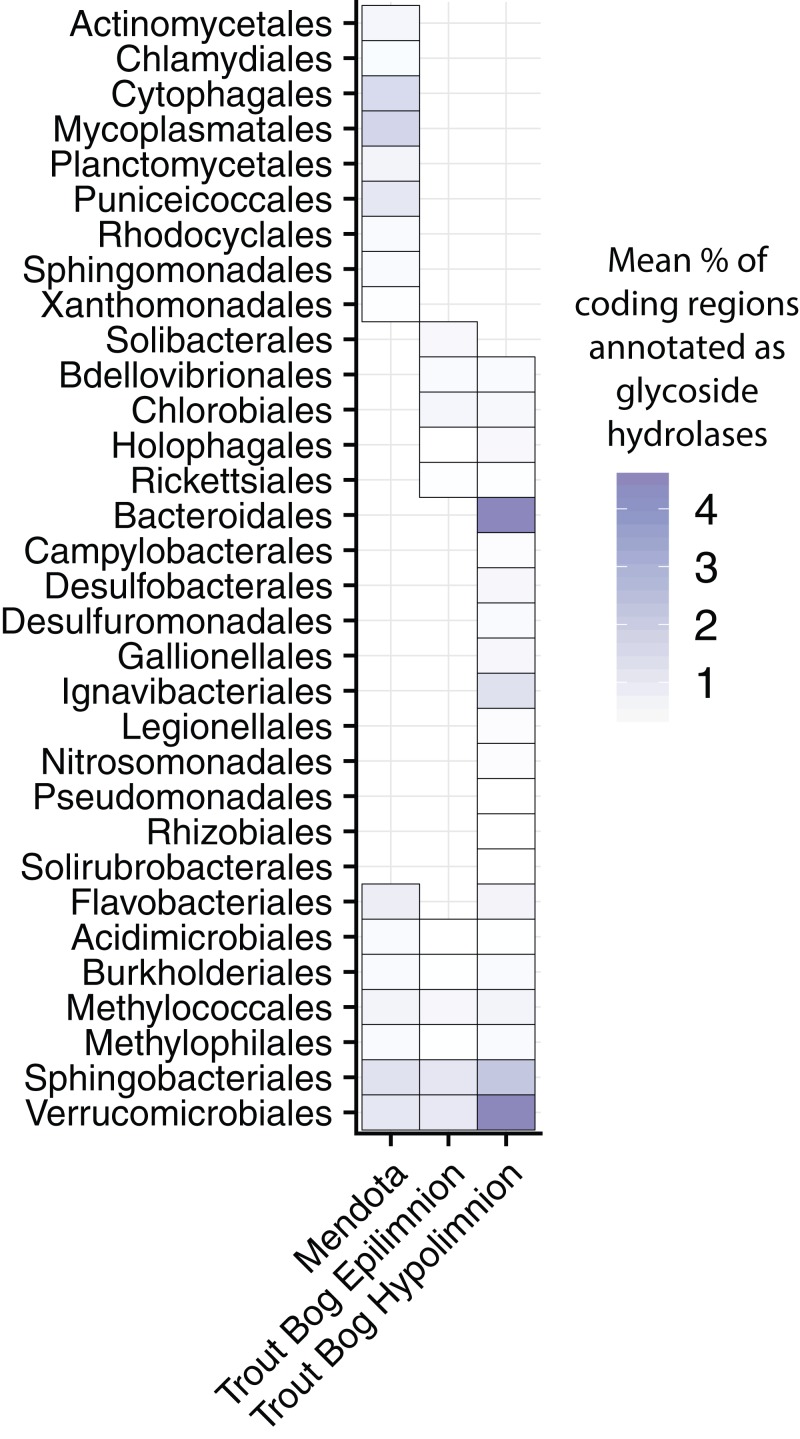
Glycoside hydrolase content in the MAGs.Annotations of GHs were used as an indication of complex carbon degradation. Genes potentially encoding GHs were identified and assigned CAZyme annotations using dbCAN2. GH coding density was calculated for each MAG and averaged by order and lake. While a few orders contained genes encoding glycoside hydrolases in all three sites, many orders were unique to each site. The orders with the highest coding densities were all found in the Trout Bog hypolimnion. Glycoside hydrolase diversity, an indicator of the range of substrates an organism can degrade, was significantly correlated with coding density (r2 = 0.92, p < 2.2 × 10−16). Proteobacteria was split into classes due to the high diversity of this phylum.